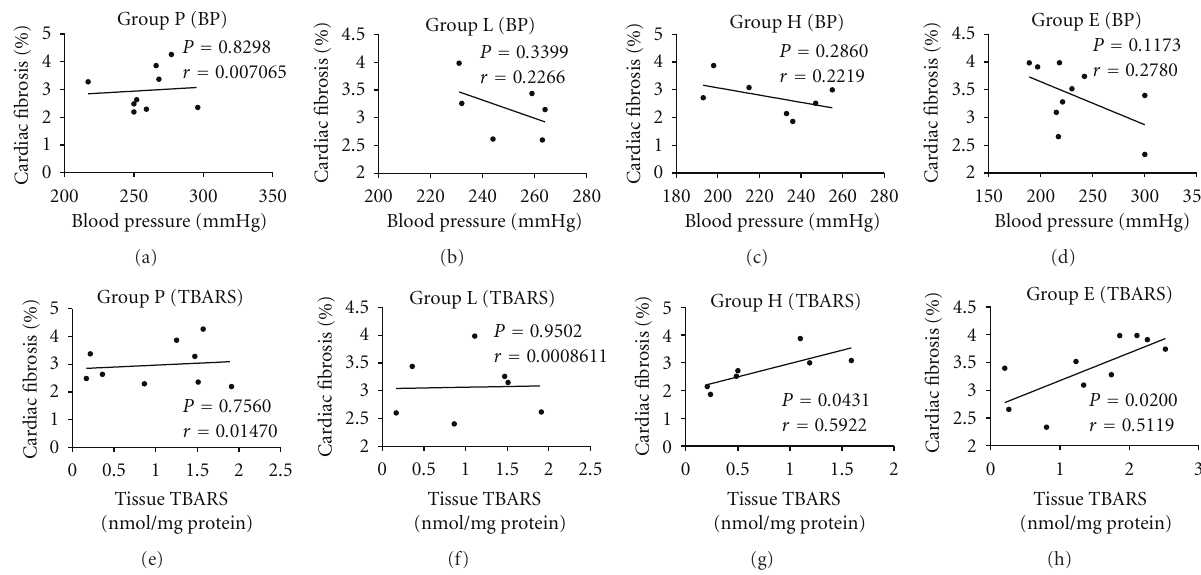
Figure 2: The coe ffi cient of correlation between cardiac fibrosis and blood pressure (mmHg)/tissue TBARS (nmol/mg protein). Tissue TBARS in Groups H and E were significantly correlated with cardiac fibrosis in the left ventricle, whereas there was no significant correlation between cardiac fibrosis and blood